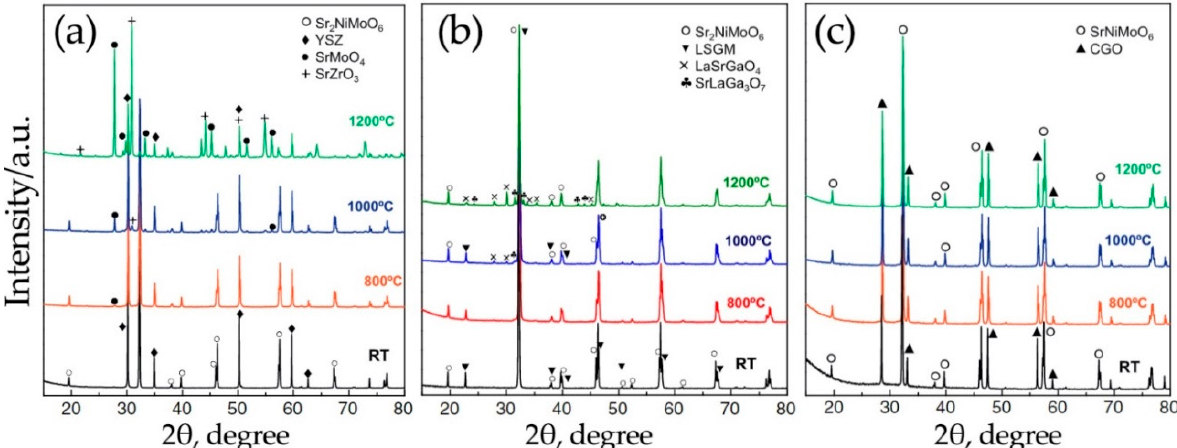
Figure 6. XRD patterns recorded for the as-prepared and calcined mixtures composed of: Sr 2 NiMoO 6– δ and yttria-stabilized zirconia (YSZ) ( a ), Sr 2 NiMoO 6– δ and LSGM ( b ) and Sr 2 NiMoO 6– δ and Ce 1–x Gd x O 2– δ (GDC) ( c ). Reproduced with permission [91]. Copyright 2013, Elsevier.